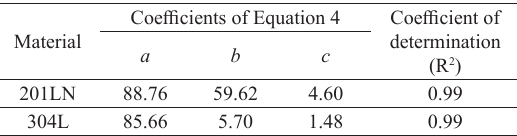
Table 4. Coefficients of Equation 4 for 201LN and 304L